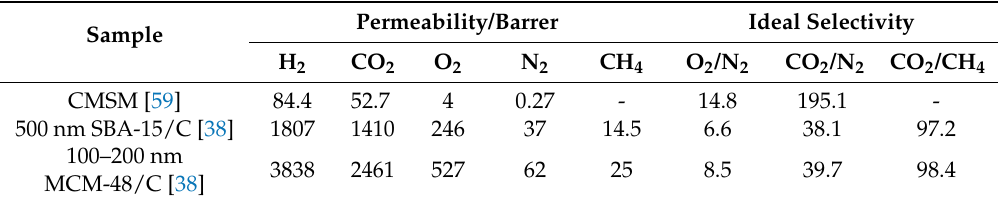
( a ) ( b ) Figure 21. Nitrogen adsorption isotherms and pore size distributions of the SBA-15/C ( a ) and MCM-48/C ( b ) hybrid membranes [38]. Table 9. Gas permeability and selectivity of pure CMS membrane and ordered mesoporous silica/C hybrid CMS membranes.